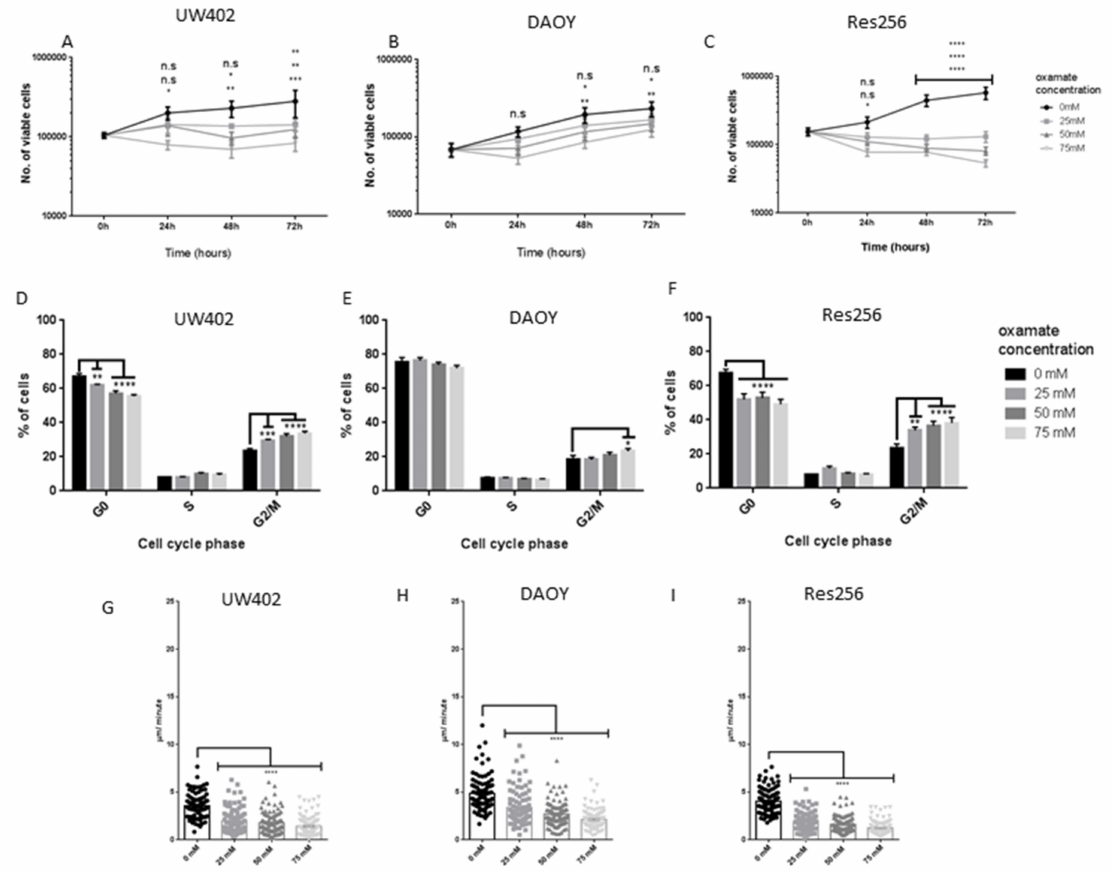
Figure 2. Effects of oxamate on MB proliferation and motility. MB cell lines were grown in the presence of 0 mM, 25 mM, 50 mM or 75 mM oxamate. ( A – C ) Number of viable cells 0–72 h after treatment counted by Vi-Cell automated cell counter ( A ) UW402, ( B ) DAOY and ( C ) Res256; ( D – F ) Mean percentage of cells in G0, S and G2/M phases of the cell cycle 48 h after treatment ( D ) UW402, ( E ) DAOY, ( F ) Res256; ( G – I ) Average velocity ( µ m/second) of individual ( G ) UW402, ( H ) DAOY and ( I ) Res256 cells over 24 h. Cells were imaged every 30 minutes and tracked manually using Volocity software. Graphs show mean with SEM. Oxamate treated samples were compared to the untreated control at each time point, not significant p > 0.05, * p ≤ 0.05, ** p ≤ 0.01, *** p ≤ 0.001, **** p ≤